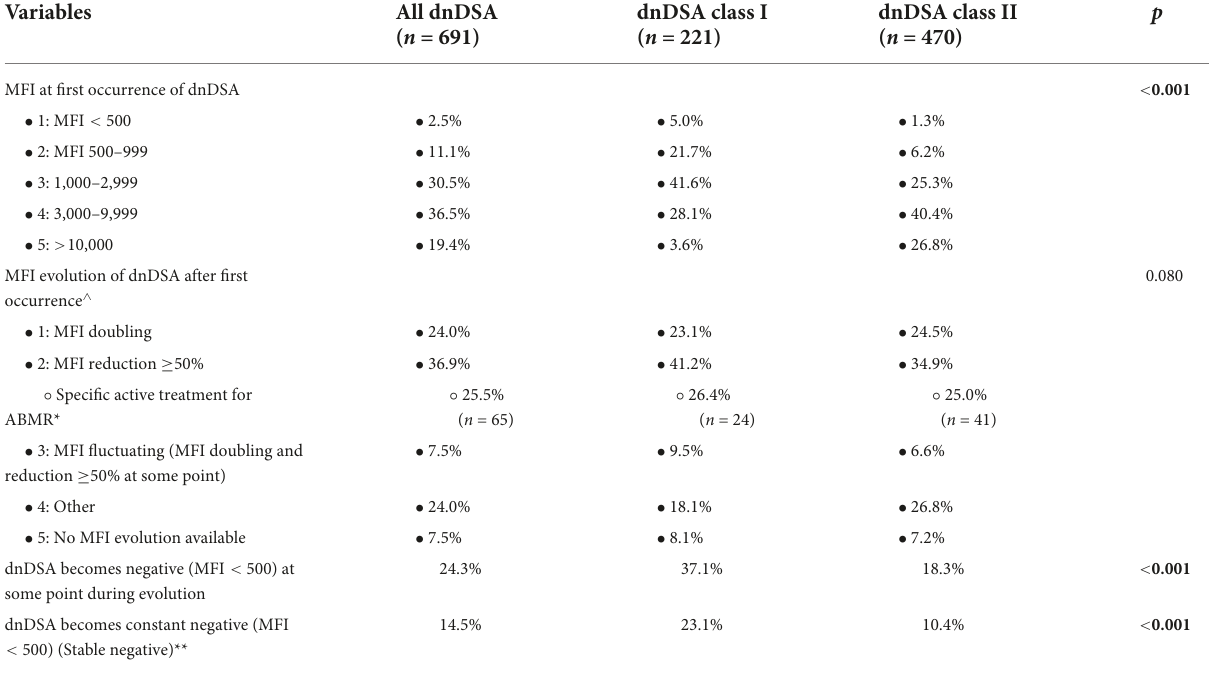
TABLE 3 MFI values at the first occurrence and MFI evolution of dnDSA analyzed by Luminex R (cid:13) .